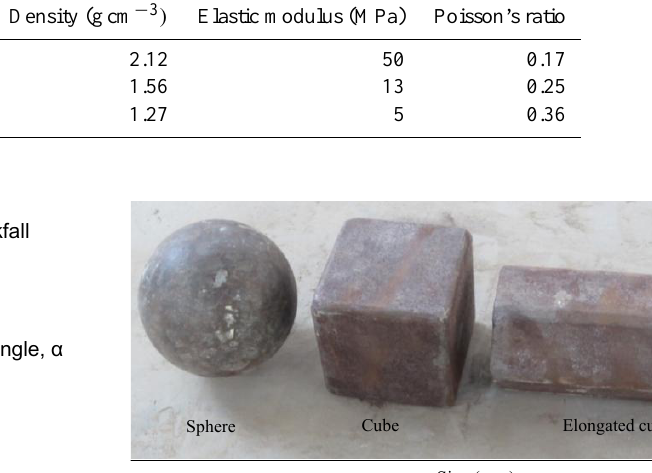
Figure 3. Schematic diagram of rockfall impacts.